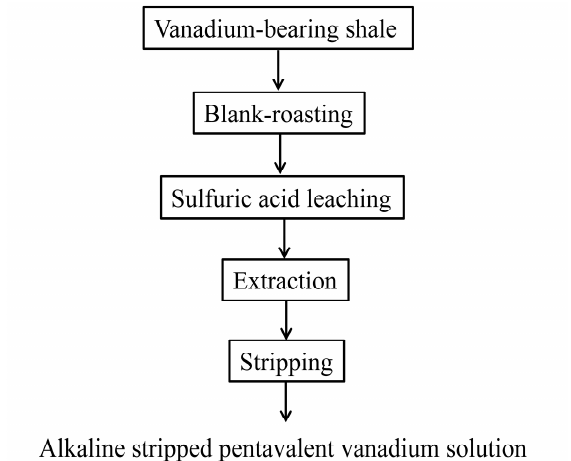
Figure 1. Typical flowsheet for alkaline stripped pentavalent vanadium solution formation.